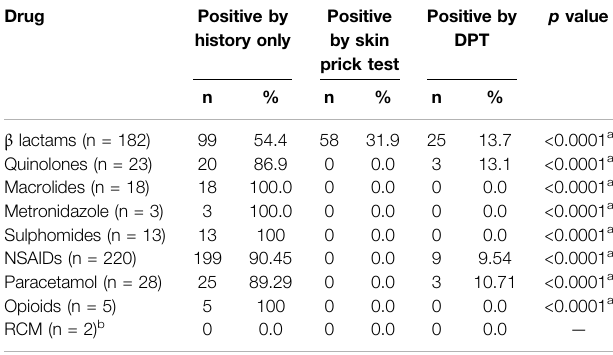
a Difference was signi fi cant statistically. b Desensitization was done for 12 patients who had reaction to